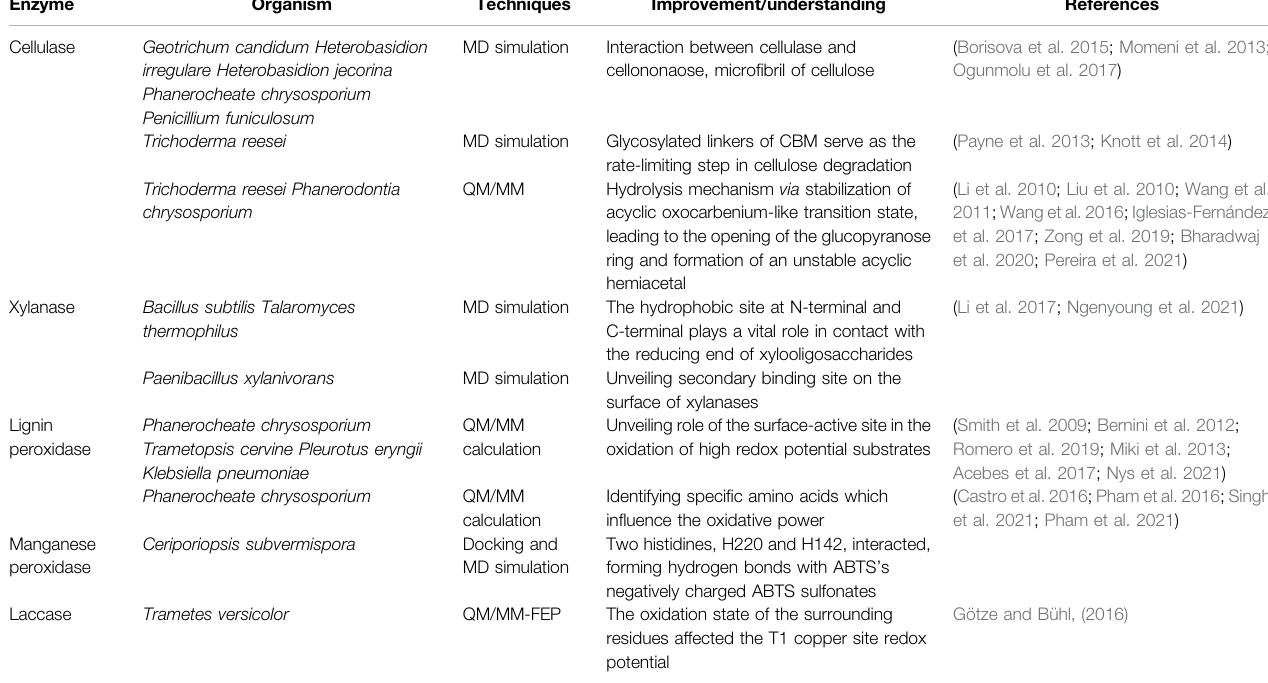
TABLE 2 | List of hydrolases and lignin-modifying enzymes engineered by protein engineering.